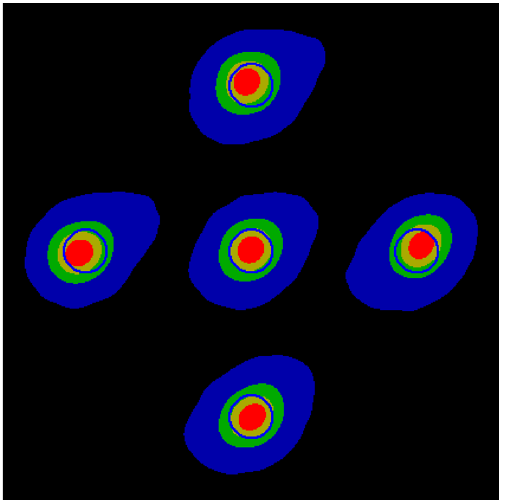
Figure 8. Effect of X- and Y-shift (see Fig. 7 for colour scale). Centre: Optimal. Left: X-shift -20. Right: X-shift + 20. Top: Y-shift − 20. Bottom: Y-shift + 20.